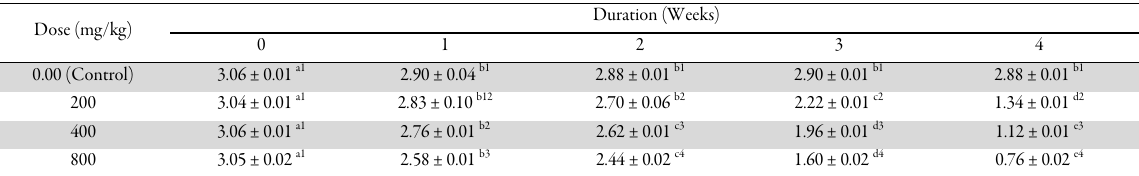
Table 4. Effect of Lipton tea aqueous extract on LDL-C (mmol/l) of normal albino rats Dose